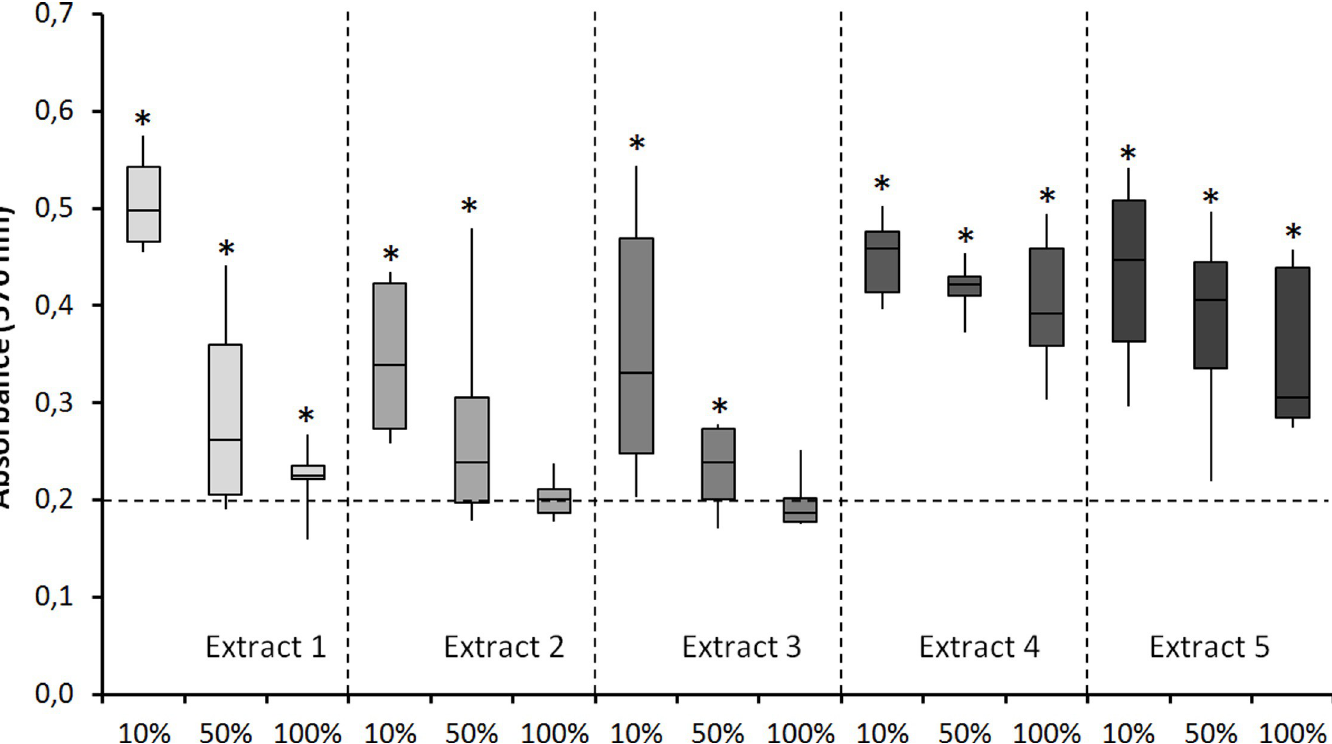
Fig 1. Effects of extracts of intervertebral disc tissue on the metabolic activity of human MSCs. Effects of extracts of IVD tissue from 5 different patients, applied at 3 concentrations on the metabolic activity of human MSCs, assessed using a MTT assay. The dashed horizontal line at 0.2 represents the mean of the control samples. All samples were tested in 8 fold. The � denotes a statistically significant difference (P < 0.05) compared to the control samples.